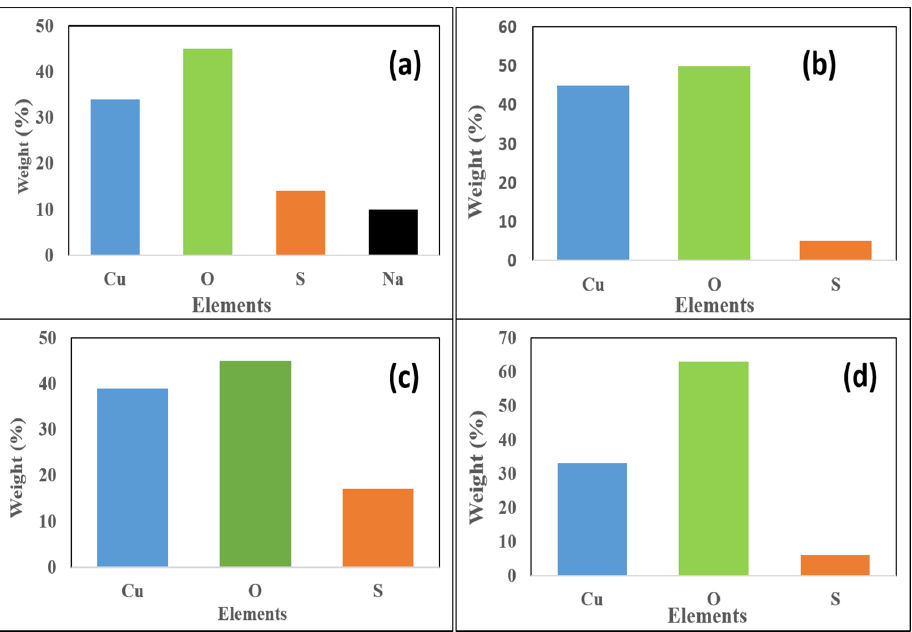
Figure 3. EDX plots of ( a ) cCuO, ( b ) wCuO, ( c ) aCuO and ( d ) eCuO